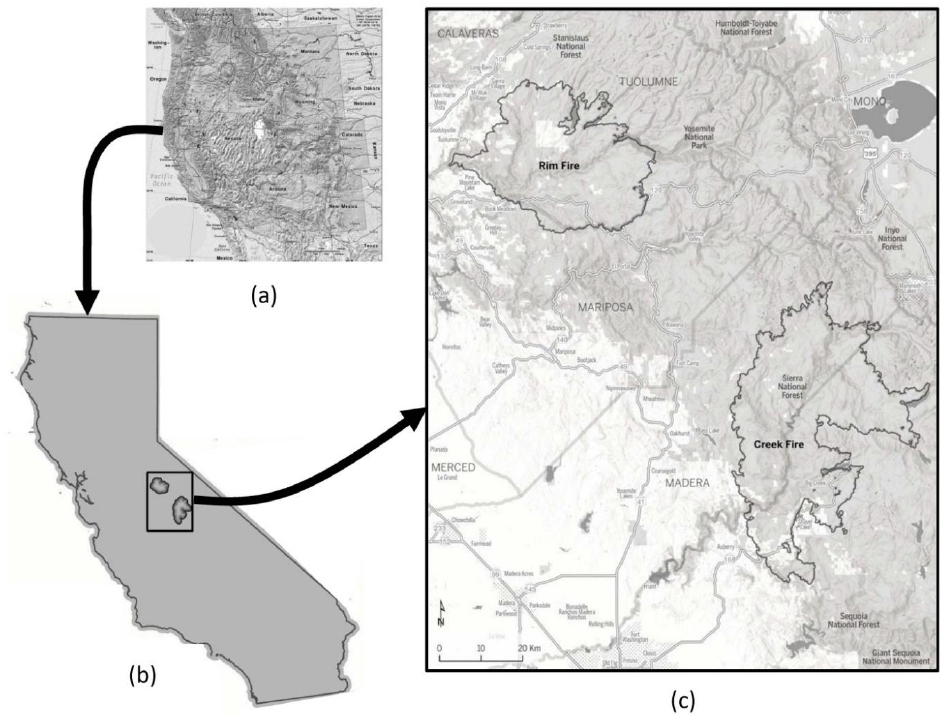
Figure 1. Location of study area in ( a ) western United States, ( b ) California, and ( c ) perimeters of 2020 Creek and 2013 Rim Fires in the Sierra Nevada Mountains, California. At the lower elevations, these forests primarily consist of Ponderosa pine ( P. pon-